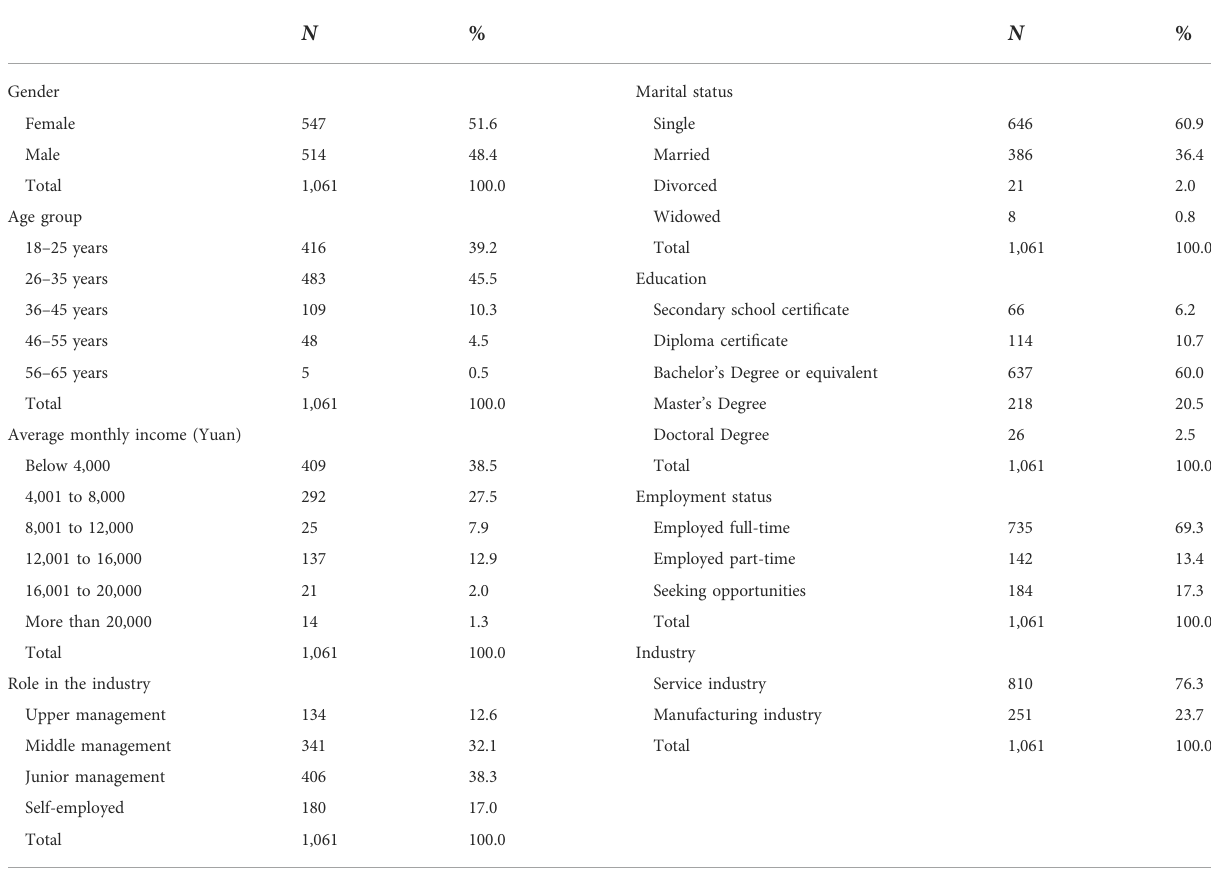
TABLE 2 Demographic characteristics.